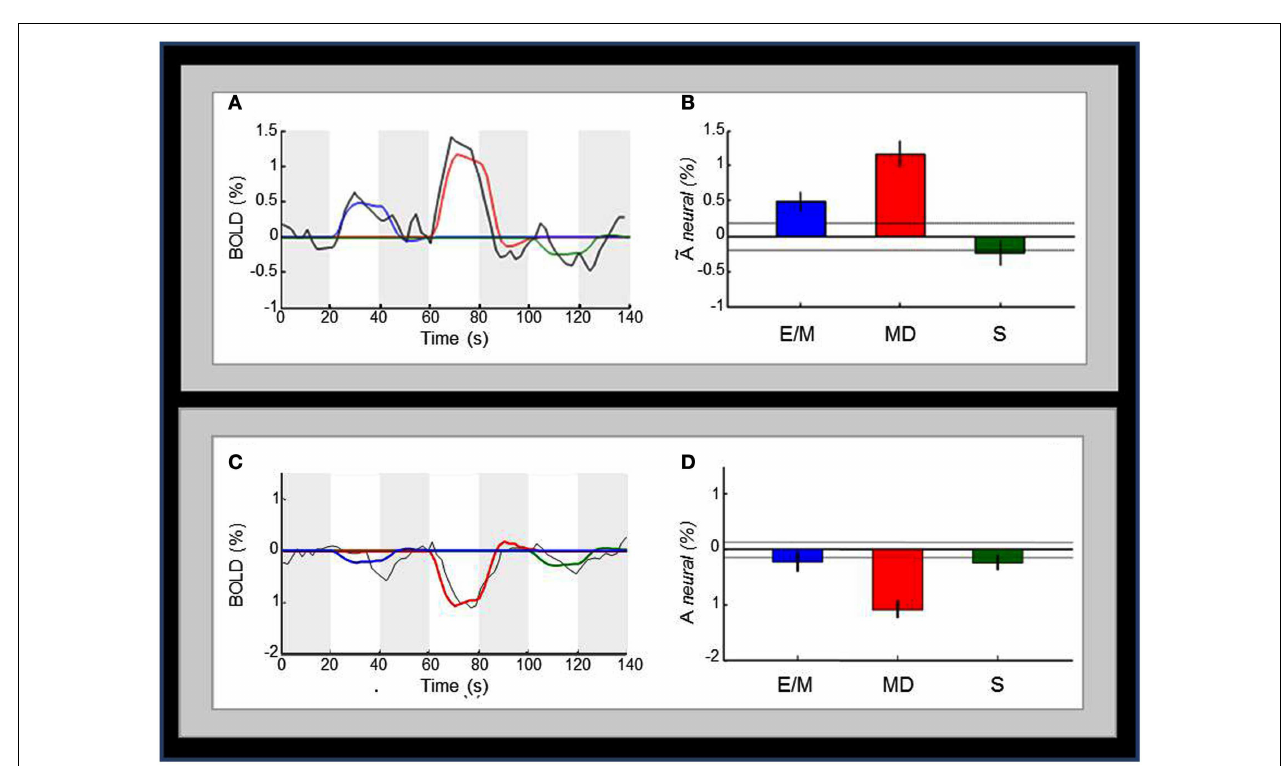
right (RH) hemispheres, with orange-yellow coloration showing the average pre/post increase in BOLD activation for MD in the CaS (V1) region.